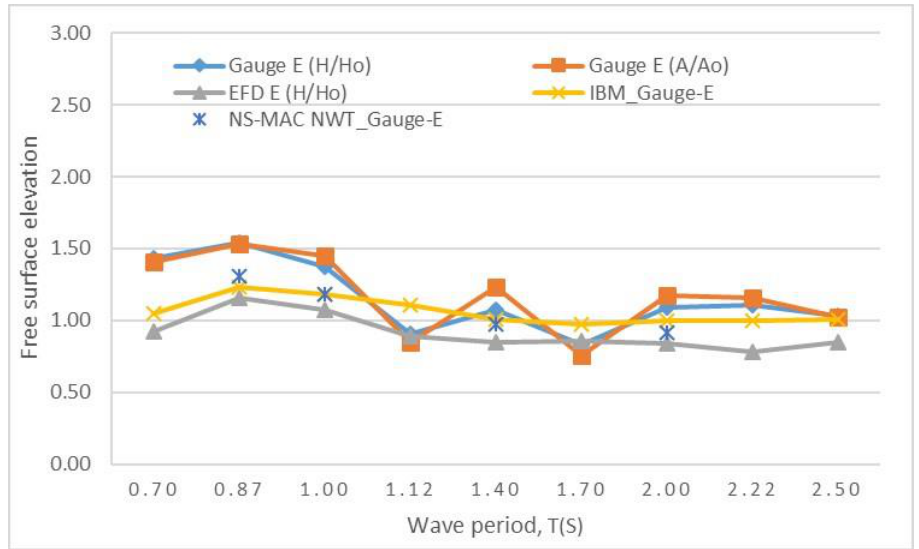
Figure 9. Comparison between CFD, experimental and numerical data of wave amplitude and heights for location E [5,25,26].